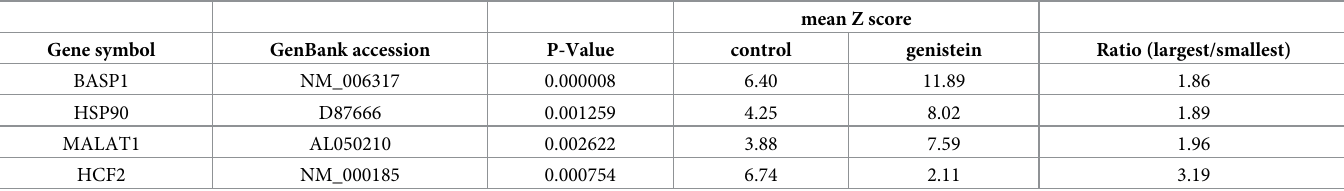
Table 1. Outlier genes in control and genistein treated